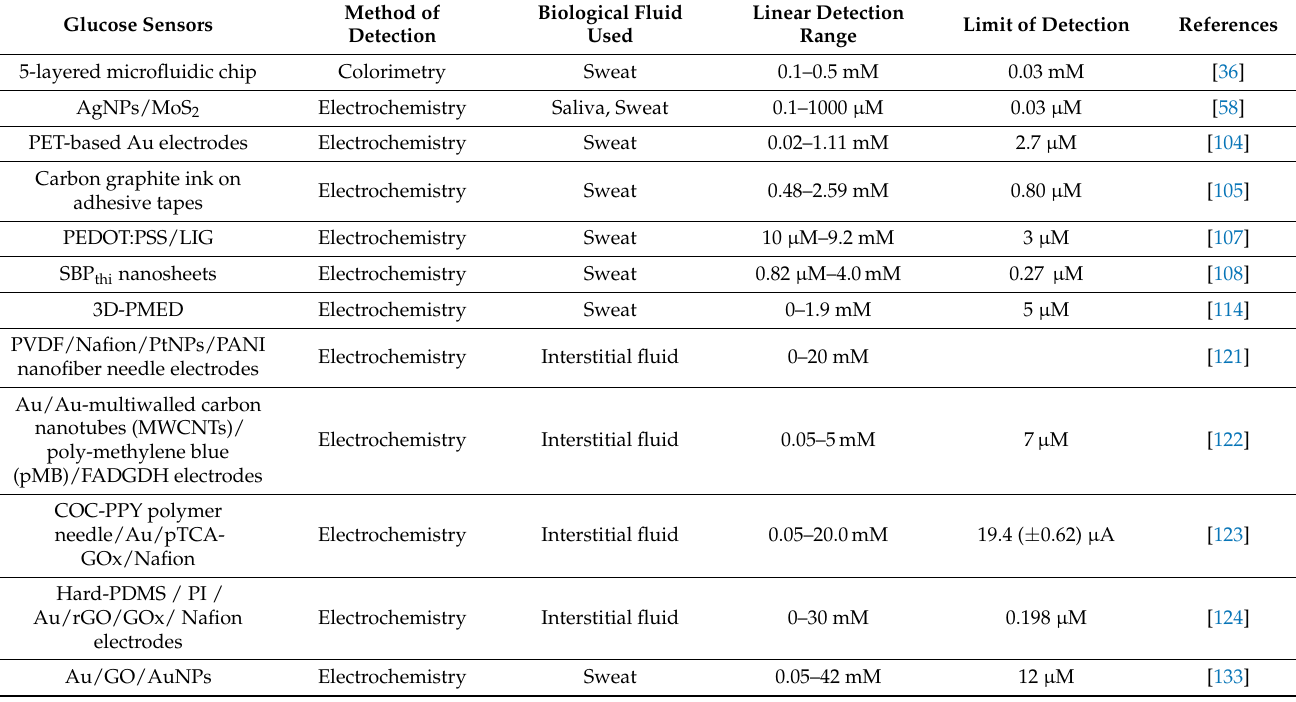
Table 4. The performance of various sweat- and interstitial fluid-based glucose